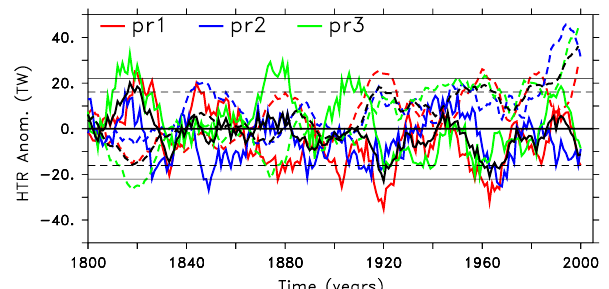
Figure 9. Time series of simulated (solid lines) atmospheric heat transports (AHTR) and (dashed lines) TOHTR at 70 ◦ N as anoma- lies w.r.t. the pre-industrial mean (coloured lines for experiments pr1, pr2, pr3; time series are shown as black dashed and solid lines denote the respective ensemble means). The horizontal black lines bracketing the zero lines are the respective 2 σ ranges derived from the PiCtrl experiment. An 11-year running mean was applied to all data